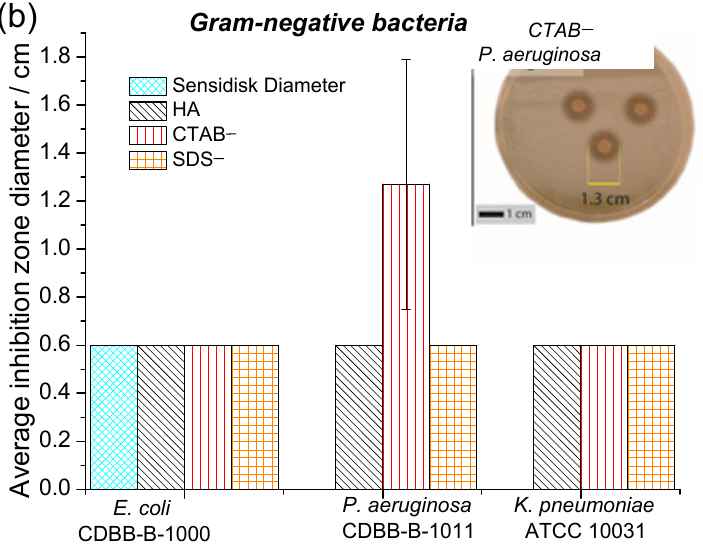
Figure 5. Inhibition zone diameter of HA, CTAB − , and SDS − , powders: ( a ) Gram-positive bacteria and ( b ) Gram-negative bacteria.